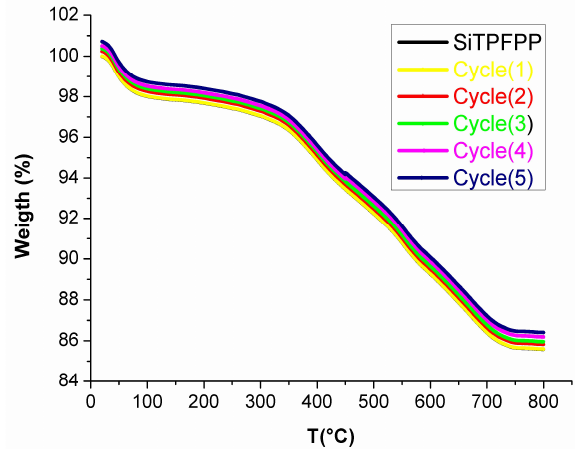
Figure 11. Thermogravimetric curves after five cycles of adsorbent regeneration and the curve before regeneration of SiTF 5 PP .